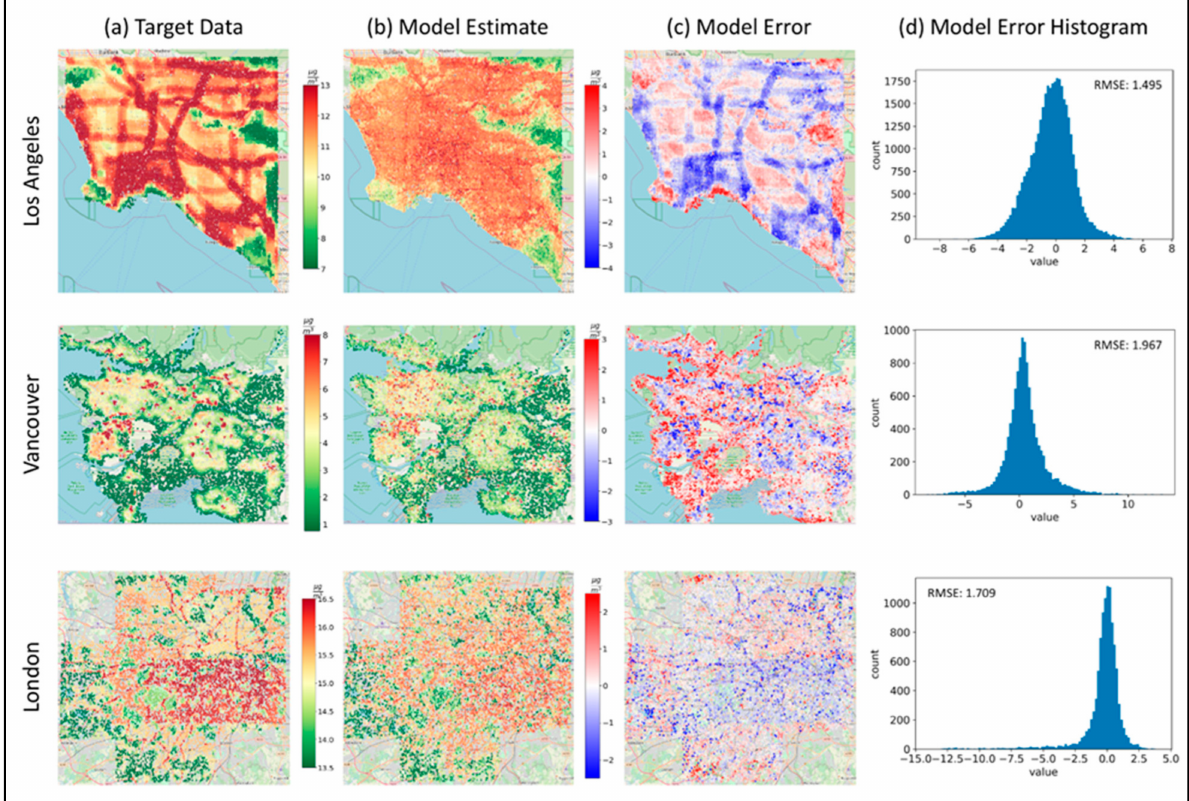
Figure 2. PM 2.5 target data, model estimates and errors. PM 2.5 target data ( a ), based on 2010 LUR data in Los Angeles, Vancouver, and London. Column ( b ) shows the 100 m model estimates of PM 2.5 annual concentrations using the testing dataset (10% of the available data for all 3 cities), and column ( c ) shows the model residuals calculated by the difference between the predicted concentrations and the target data. The residuals’ distributions are shown in column ( d